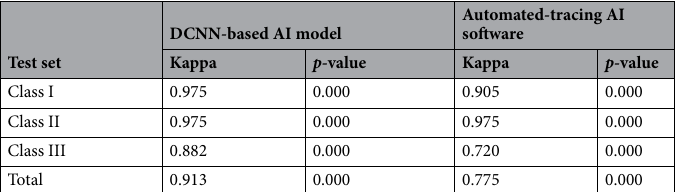
Table 3. Cohen’s kappa coefficients for agreement between the standard classification label and either DCNN- based AI model or automated-tracing AI software. DCNN, deep convolutional neural network.